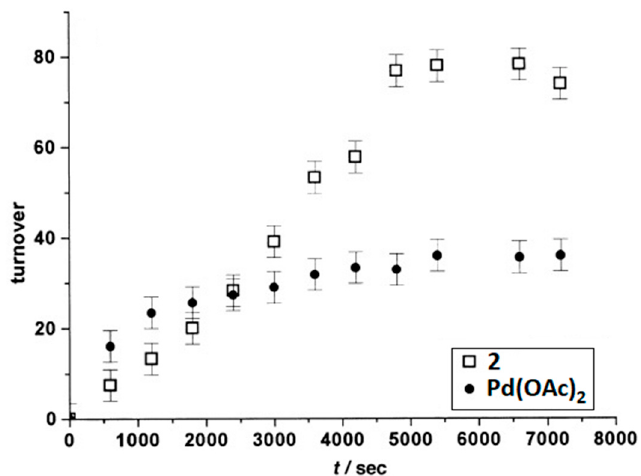
Figure 1. The catalytic turnovers versus time of gel produced from 2 , and Pd(OAc) 2 . Reproduced with permission from Reference [55].